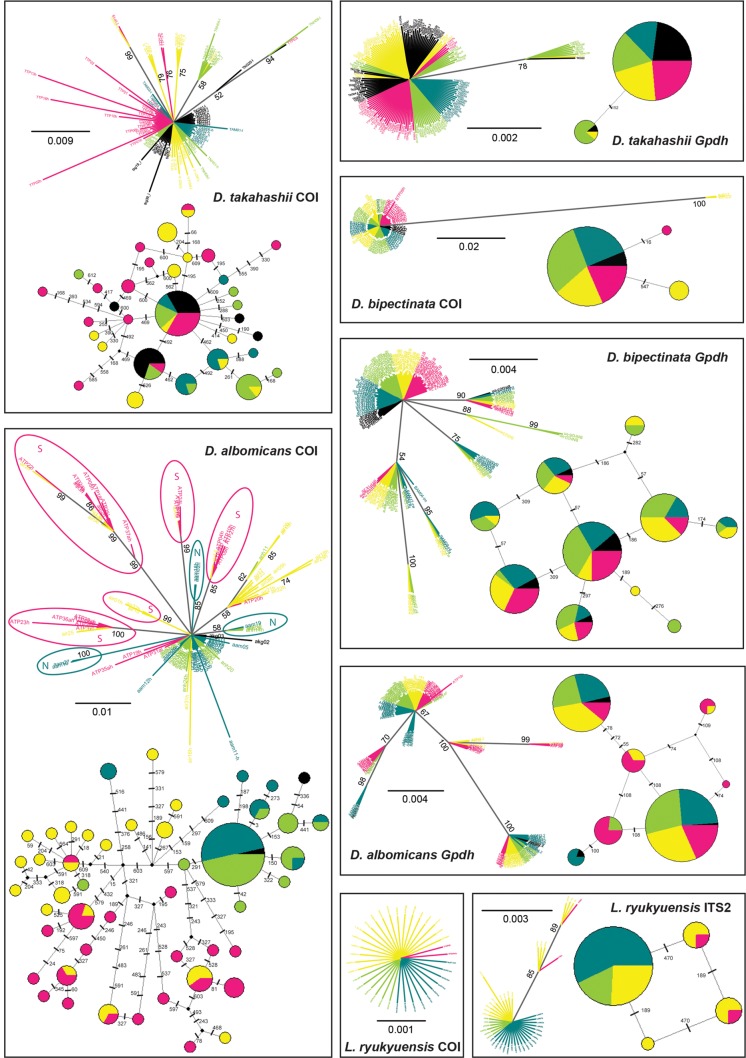
Unrooted consensus trees estimated with Bayesian inference and MJ networks.Trees and networks for D. takahashii COI (612 bp) and Gpdh (431 bp), D. bipectinata COI (574 bp) and Gpdh (340 bp), D. albomicans COI (611 bp) and Gpdh (401 bp), and L. ryukyuensis COI (649 bp) and ITS2 (586 bp) are given. Colors represent different populations: KG (black), AM (blue), NH (green), IR (yellow), and TP (red). Posterior probabilities of 0.5 or greater are shown.